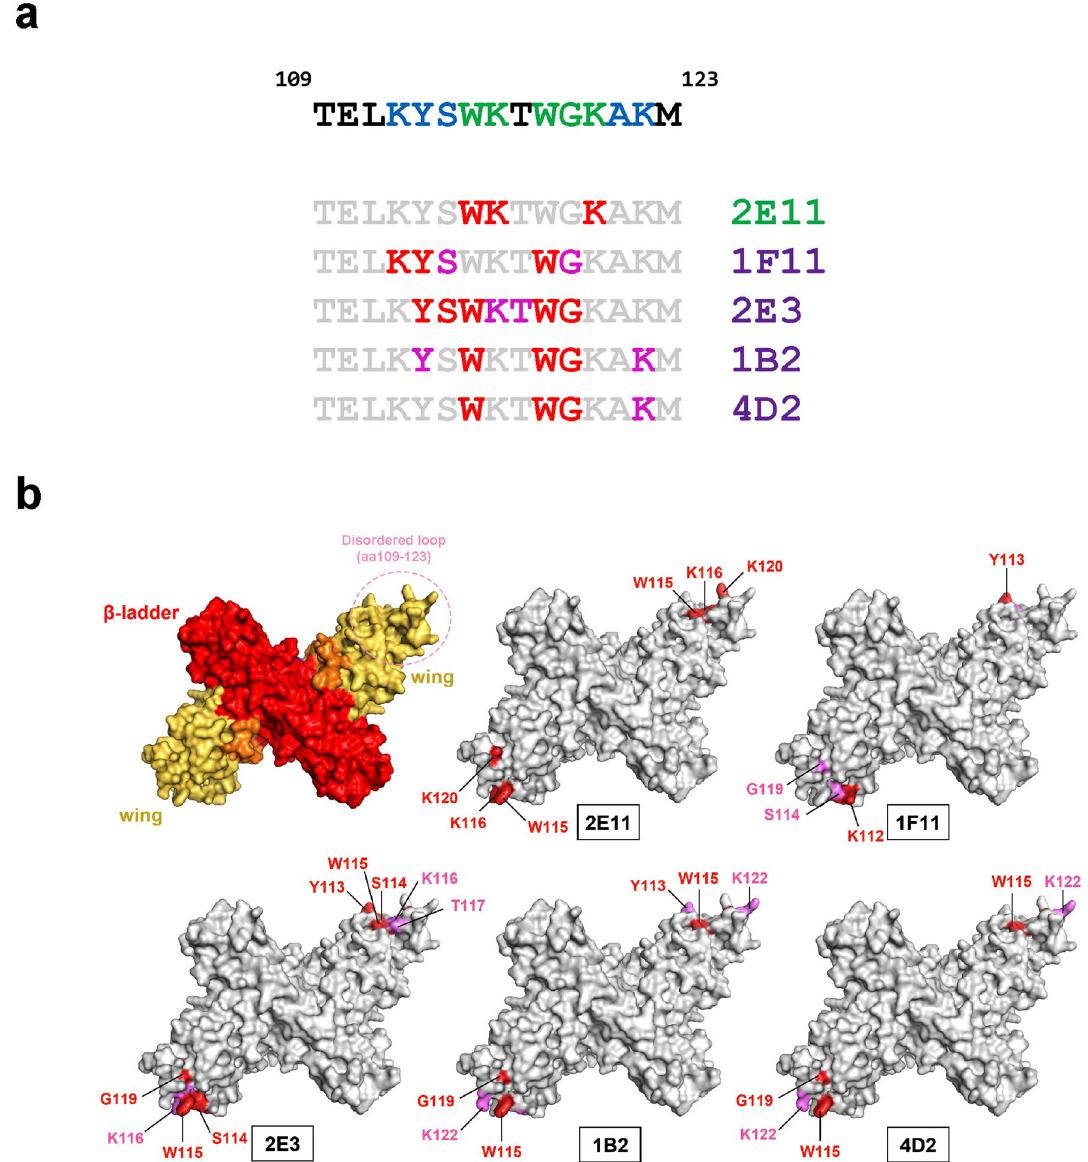
flaviviruses (green). The critical binding residues of five anti-NS1 antibodies are highlighted in red (strong) and pink (moderate). ( b ) Critical binding residues of each mAbs were depicted on dimeric NS1 structures in PyMol; strong (red) and moderate residues (pink) are